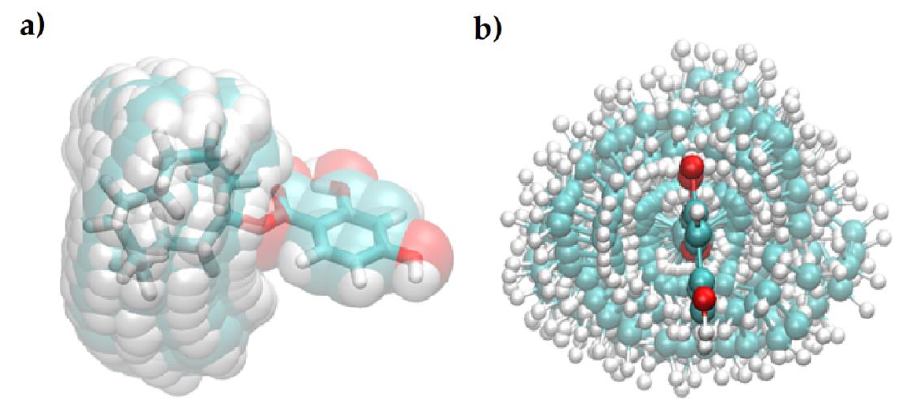
Figure 3. Possible shapes of cavities formed by different conformers of CDHB.